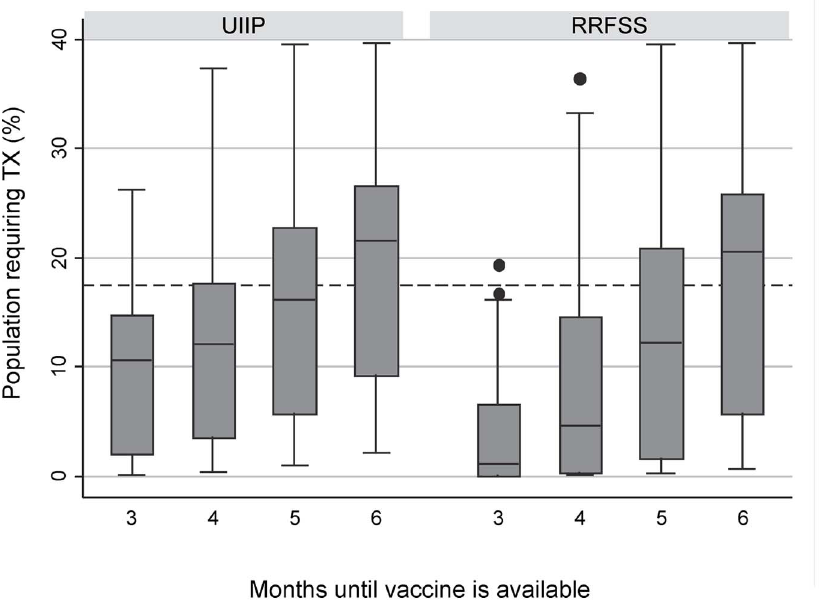
Figure 3. Projected range of treatment required depending on the level of vaccine coverage in the population. The proportion of the Canadian population expected to require antiviral treatment in the presence of a safe and effective pandemic vaccine when different vaccine coverage levels are considered [UIIP – Ontario Universal Influenza Immunization Program age-specific coverage, RRFSS – Ontario Rapid Risk Factor Surveillance System age-specific coverage estimates]. The dashed line represents the proportion of the Canadian population who would be able to be treated by our existing stockpile (17.5%).